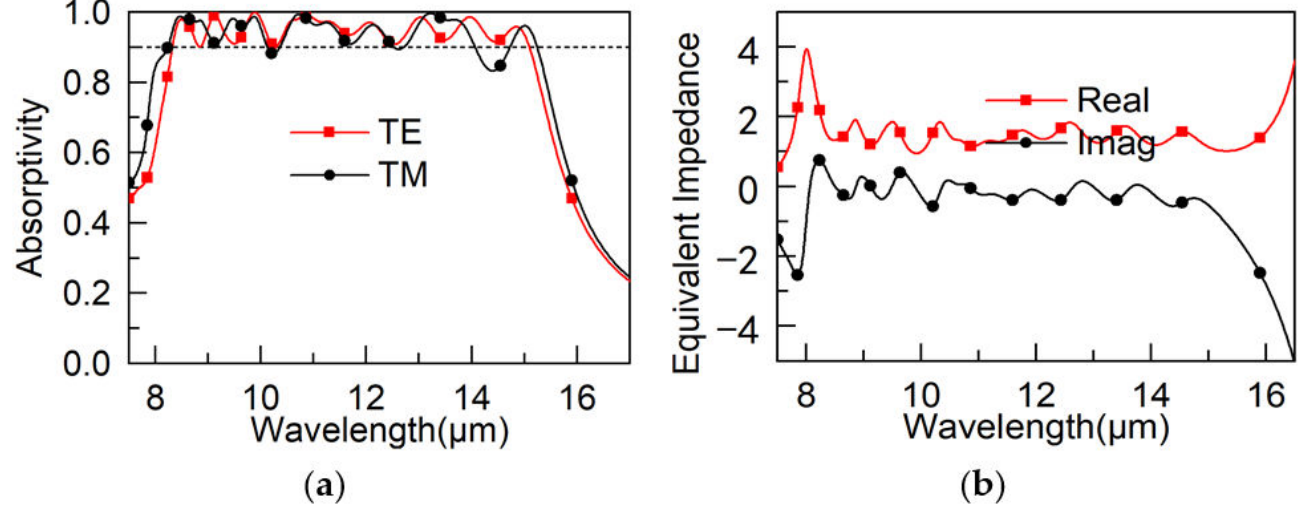
Figure 2. ( a ) Absorptivity of the MA; ( b ) real and imaginary parts of equivalent impedance of the